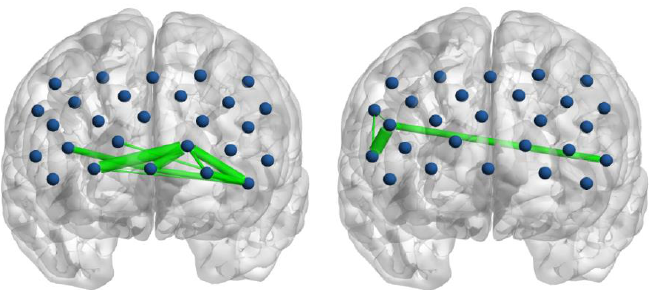
Figure 4. The results of functional connectivity. The red lines denote increased functional connectivity in the Xining group compared with the Hangzhou group, while green lines denote decreased functional connectivity. The thickness of the line indicates the strength of the connection. The blue dots denote 27 measurement channels.